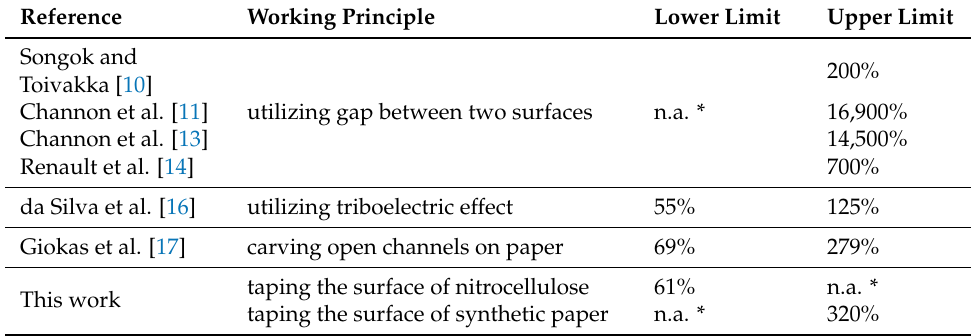
Table 1. Comparison between our work and other methods for flow rate